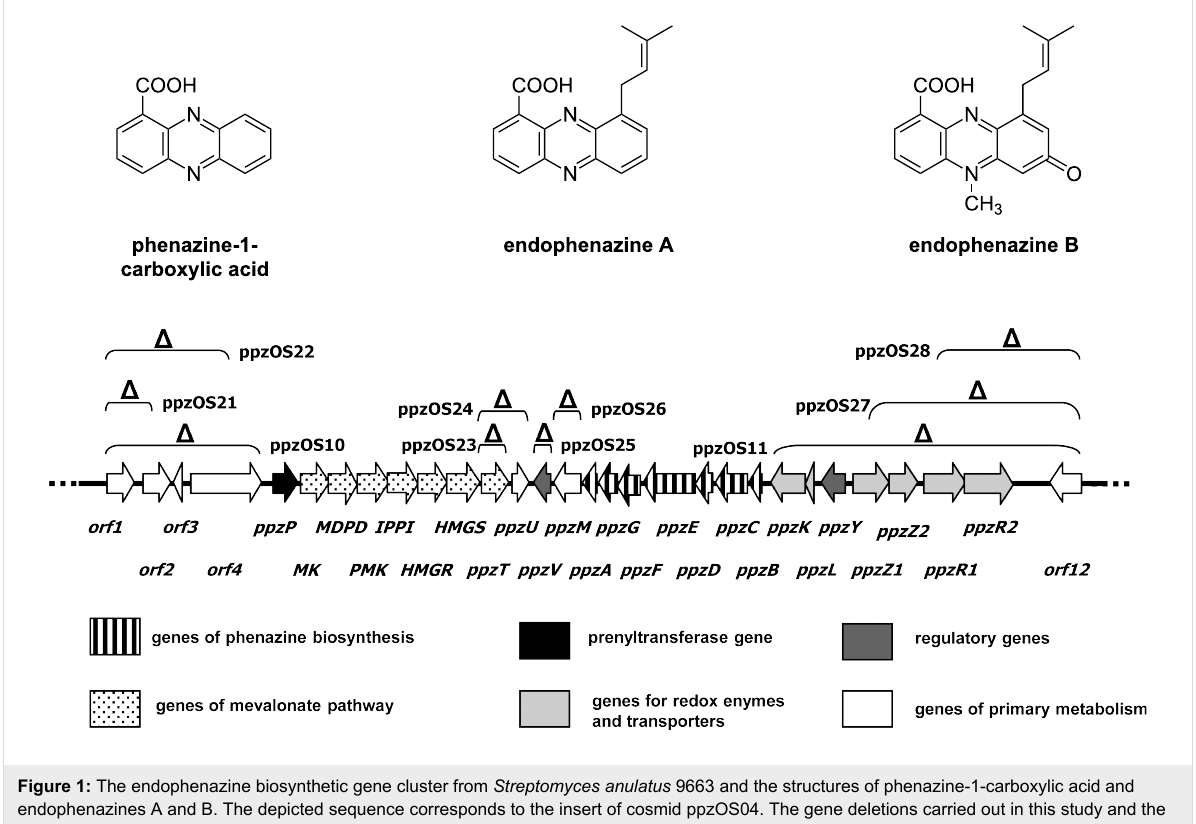
Figure 1: The endophenazine biosynthetic gene cluster from Streptomyces anulatus 9663 and the structures of phenazine-1-carboxylic acid and endophenazines A and B. The depicted sequence corresponds to the insert of cosmid ppzOS04. The gene deletions carried out in this study and the names of the resulting constructs are